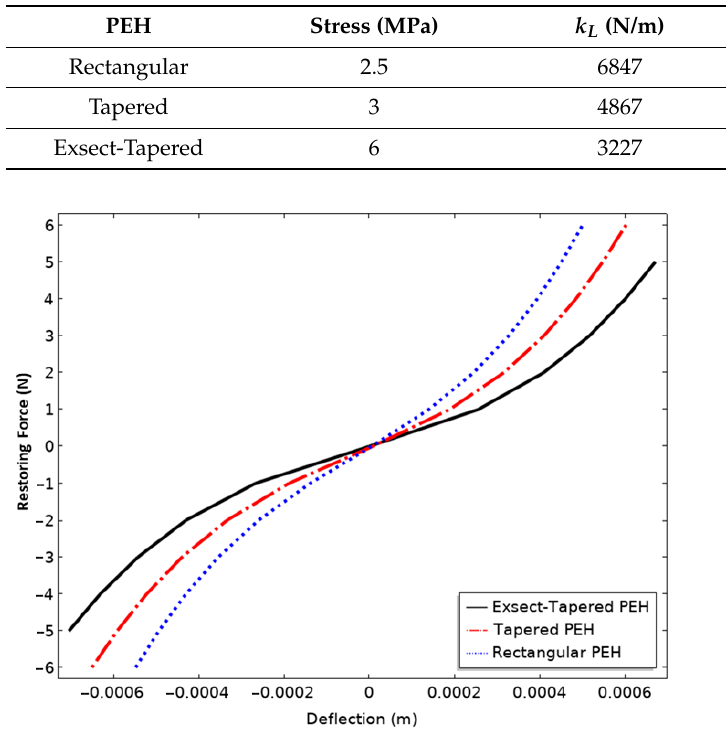
Figure 5. The restoring force of the spring vs. deflection amplitude of different nonlinear PEHs. Table 2. Comparison of stiffness and stiffness coefficients of different PEHs.